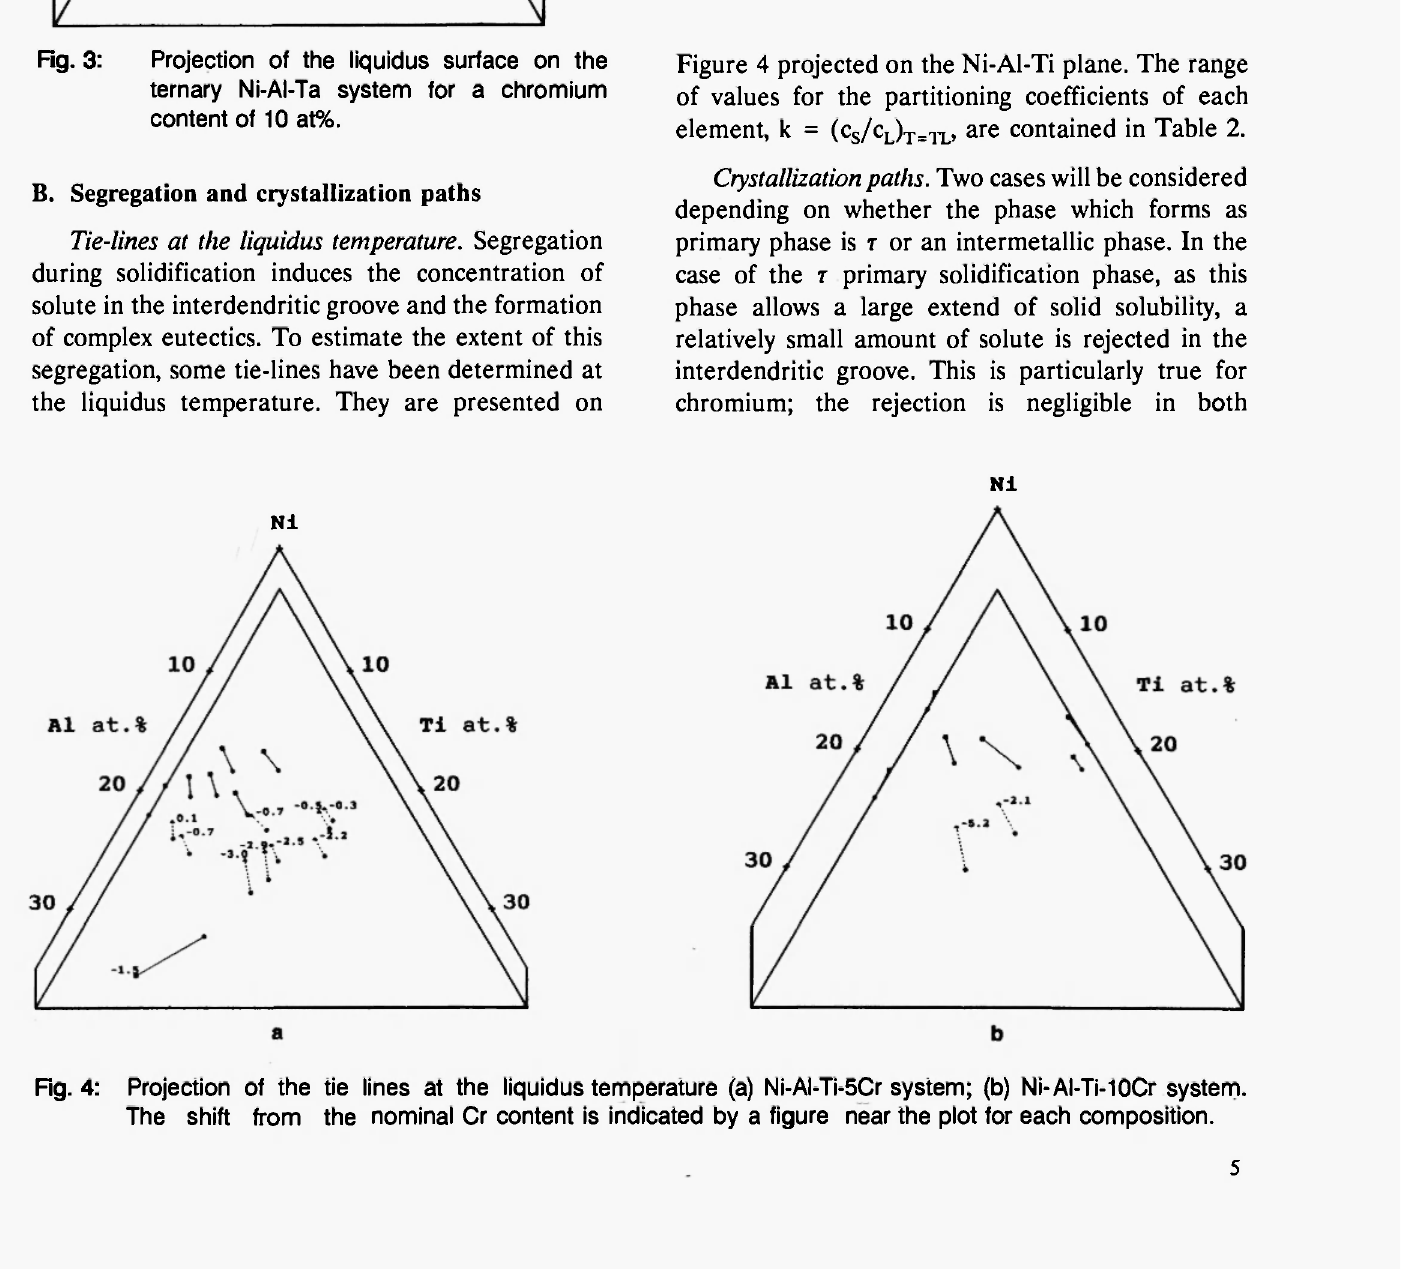
Fig. 3: Projection of the liquidus surface on the ternary Ni-AI-Ta system for a chromium content of 10 at%.